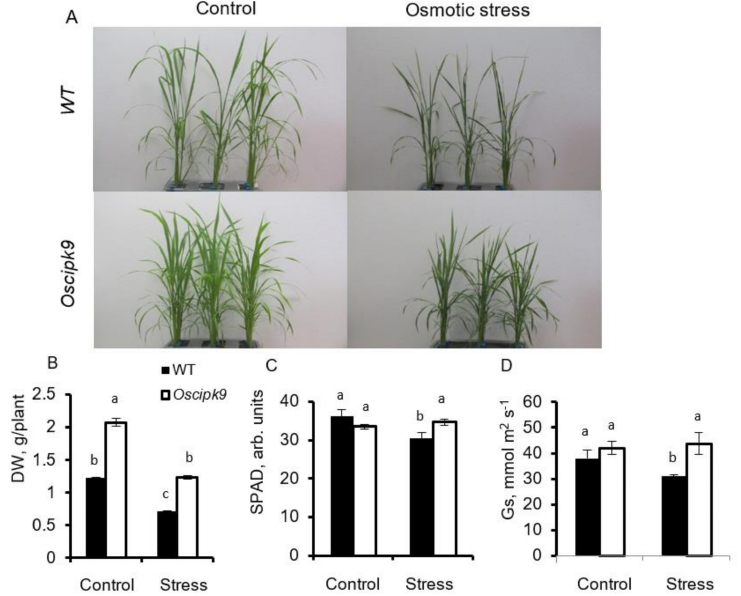
Figure 3. Effect of osmotic stress on growth and phenotype of Oscipk9 and WT plants. Osmotic stress was induced by adding 11.8% ( w / v ) of PEG4000 (imposing an osmotic stress of 0.362 MPa) to the hydroponics growth solution. ( A ) plant phenotype; ( B ) plant dry weight; ( C ) chlorophyl content (SPAD values); and ( D ) stomatal conductance. Closed bars-WT; open bars- Oscipk9 mutant line. Data are the mean ± SE ( n = 18). Data labelled with different low-case letters is significantly different at p <